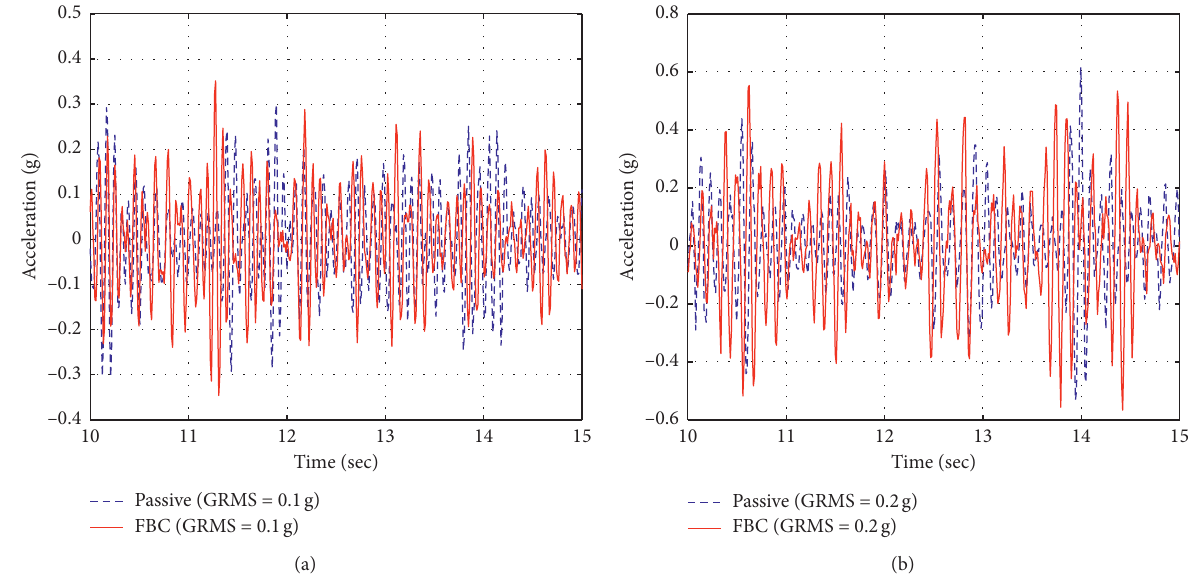
Figure 11: Acceleration response. (a) Protected structure. (b)